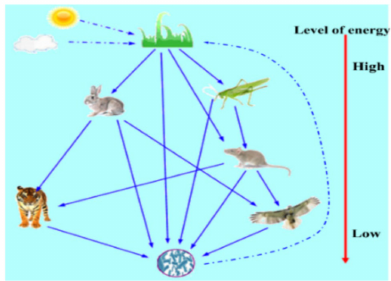
Figure 5. Energy flow in an ecosystem.